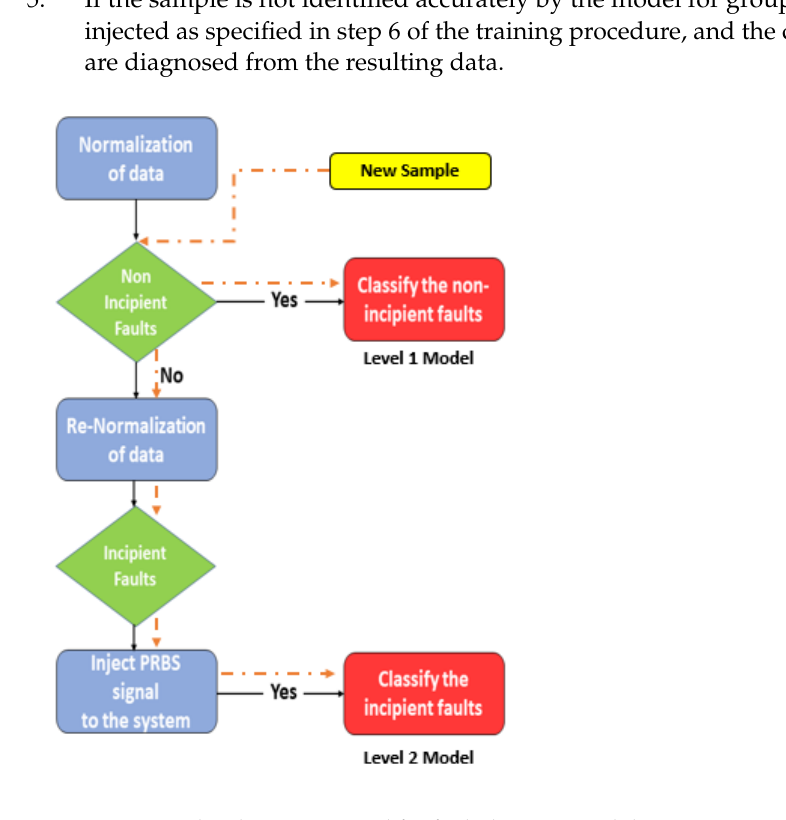
Figure 5. Hierarchical structure used for fault detection and